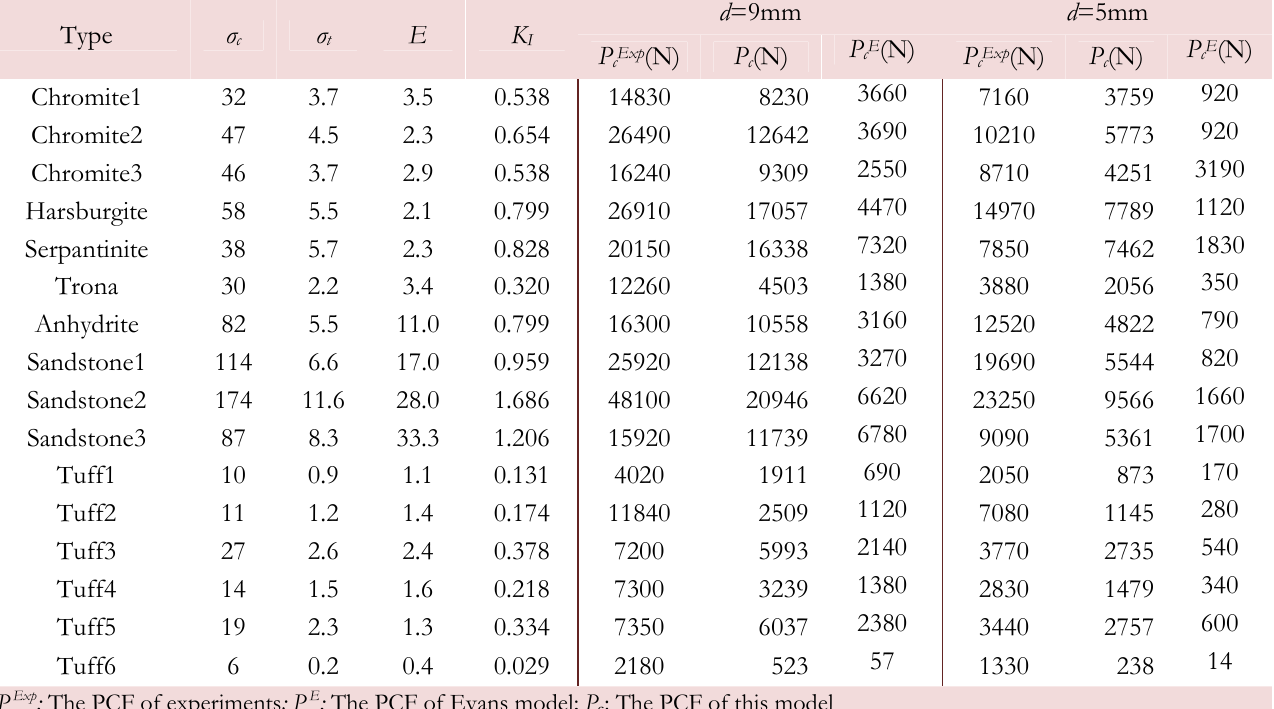
Table 2: Rock mechanical property and the